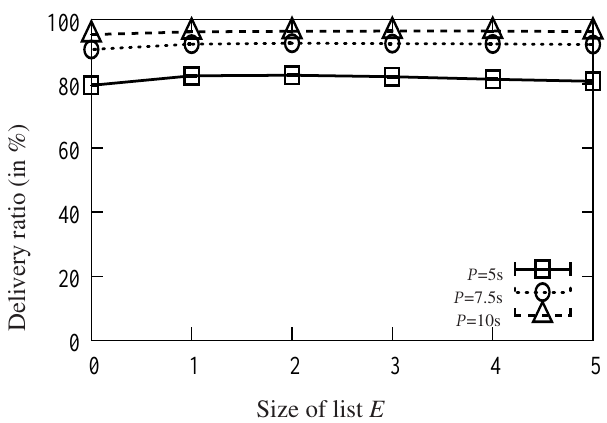
Figure 4. Impact of the size of list E of SLACK-MAC on the packet delivery ratio, with | R | = 2 | E | and a duty-cycle of 1%, where P is the traffic generation period.